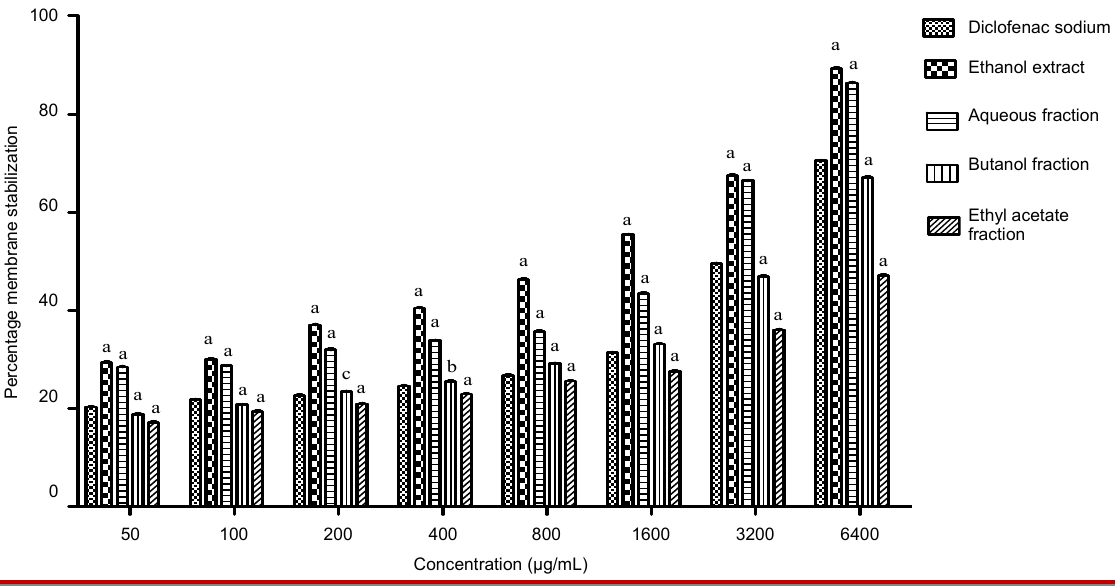
Figure 3: Effect of Ephedra gerardiana on human red blood cell membrane stabilization. Results are expressed as mean ± SEM (n=3), using two way ANOVA followed by Bonferroni posttest. a p<0.001, b p<0.01, c p<0.05 when compared to